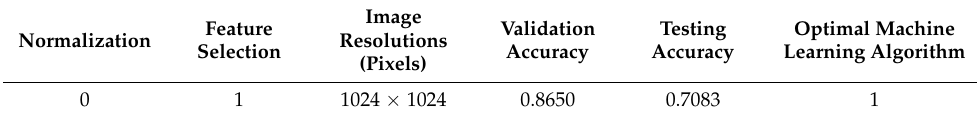
Table 2. Validation and testing five-category accuracies of the optimal CAD with texture analysis in the private dataset. Note: The optimal CAD was selected based on the validation accuracies of Table S3.